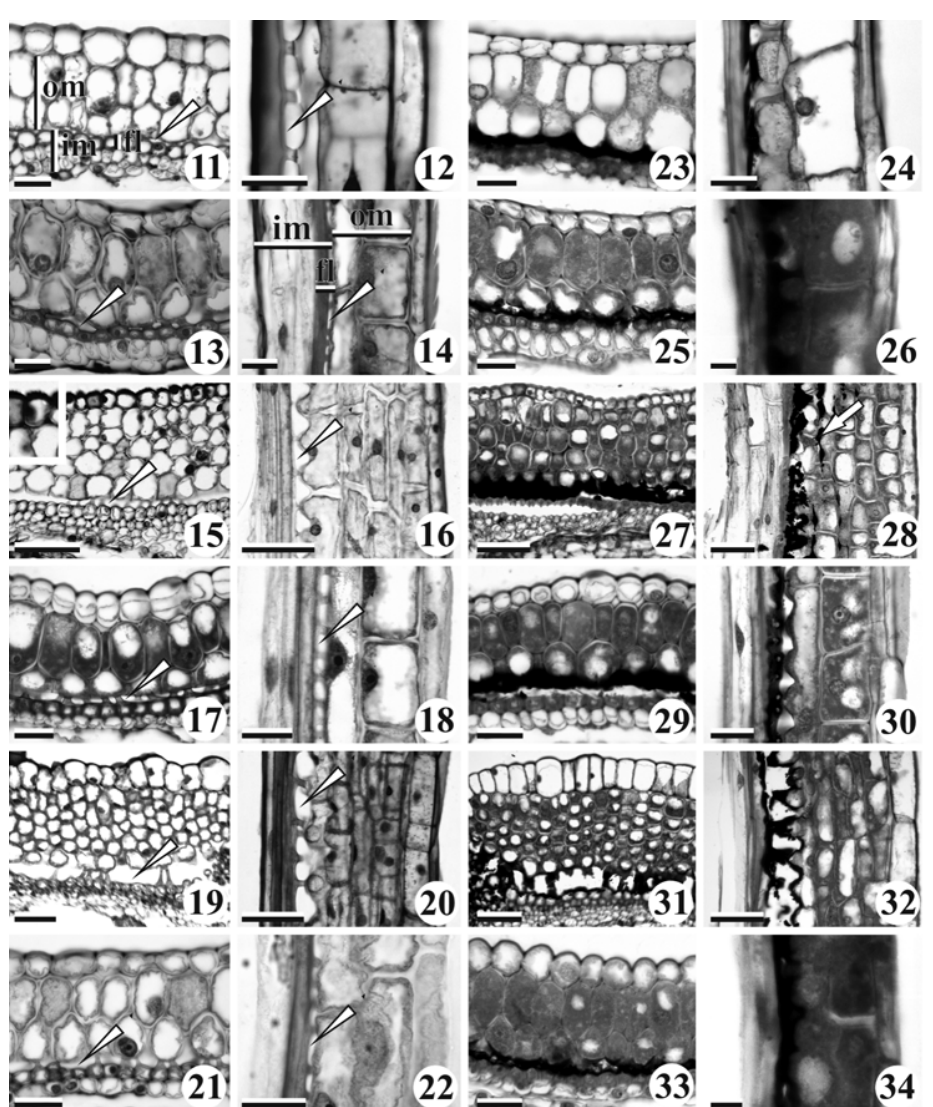
Fig. 2 – Pericarp during development. From left to right, first and third columns – Transversal sections. Second and fourth columns – Longitudinal sections. Figs. 11-22 – Immature pericarp initiating the formation of schizogenous spaces (arrowhead). Figs. 23-34 – Pericarp during maturation, with phytomelanin deposits. Figs. 11-12, 23-24 – Campuloclinium macrocephalum . Figs. 13-14, 25-26 – Chromolaena stachyophylla . Figs. 15-16, 27-28 – Mikania micrantha ; note phytomelanin deposits on the outer mesocarp (arrow). Figs. 17-18, 29-30 – Praxelis pauciflora .